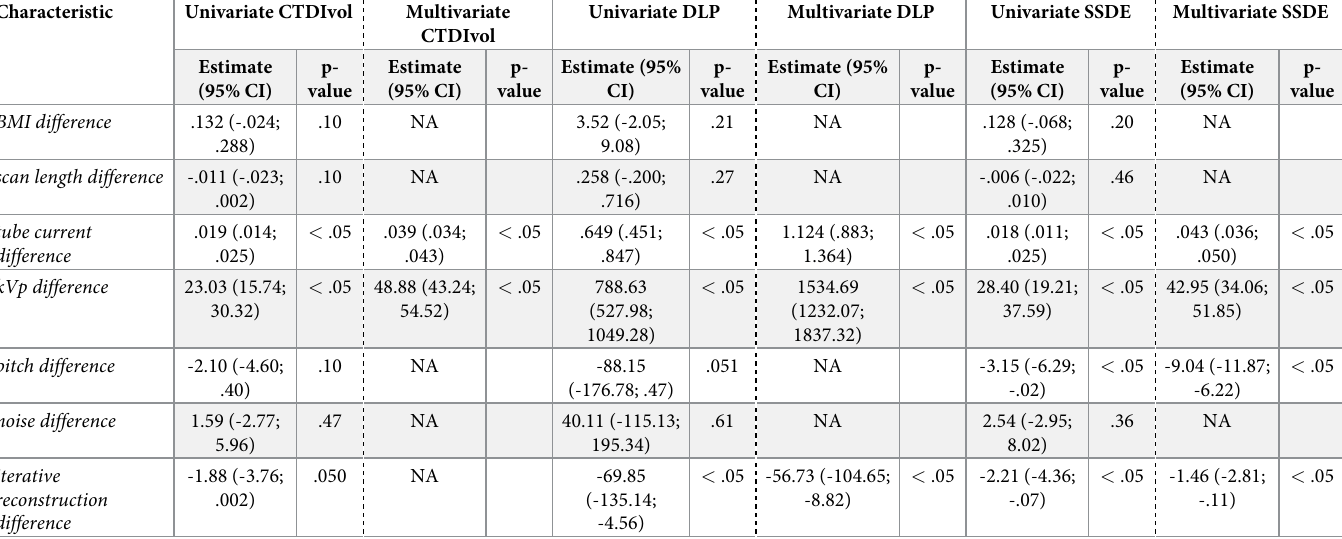
Table 2. Results of intraindividual analysis of chest CTs for the dose estimate parameter CTDIvol, DLP and SSDE. Characteristic Univariate